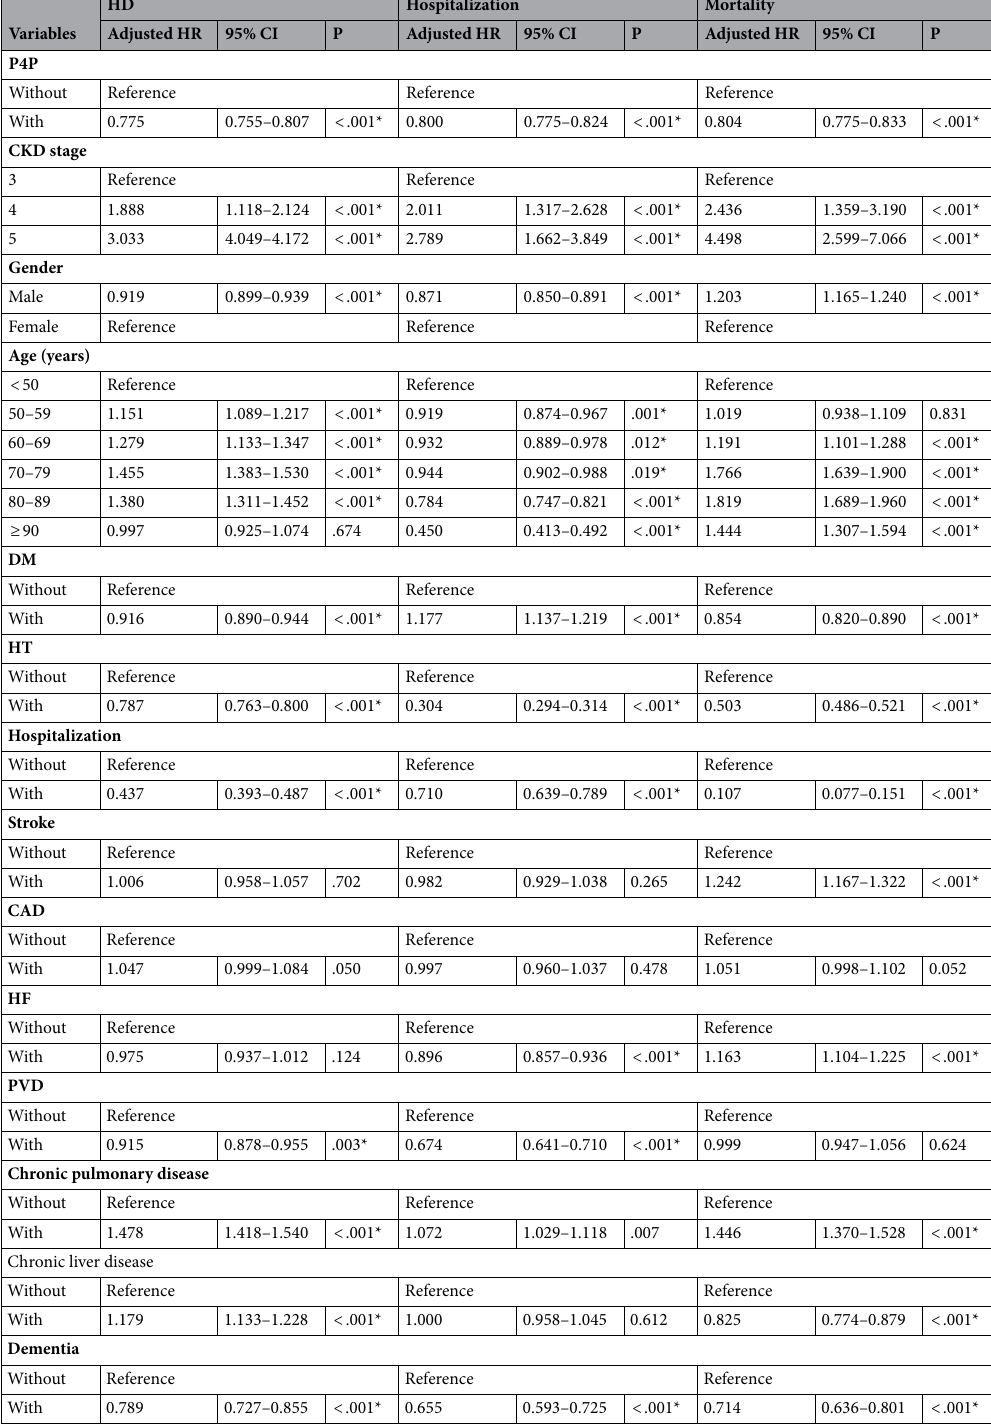
Table 2. Hazard ratio of hemodialysis, hospitalization, and mortality in patients with CKD stages 3–5 in the pay for performance program in the cox model with competing risks. Adjusted HR: Adjusted variables listed in the table. *P < 0.05; statistical significance. Abbreviations CAD = coronary artery disease; CI = confidence interval; CKD = chronic kidney disease; DM = diabetes mellitus; HD = hemodialysis; HR = hazard ratio; HT = hypertension; HF = heart failure; PVD = peripheral vascular disease; P4P = pay for performance